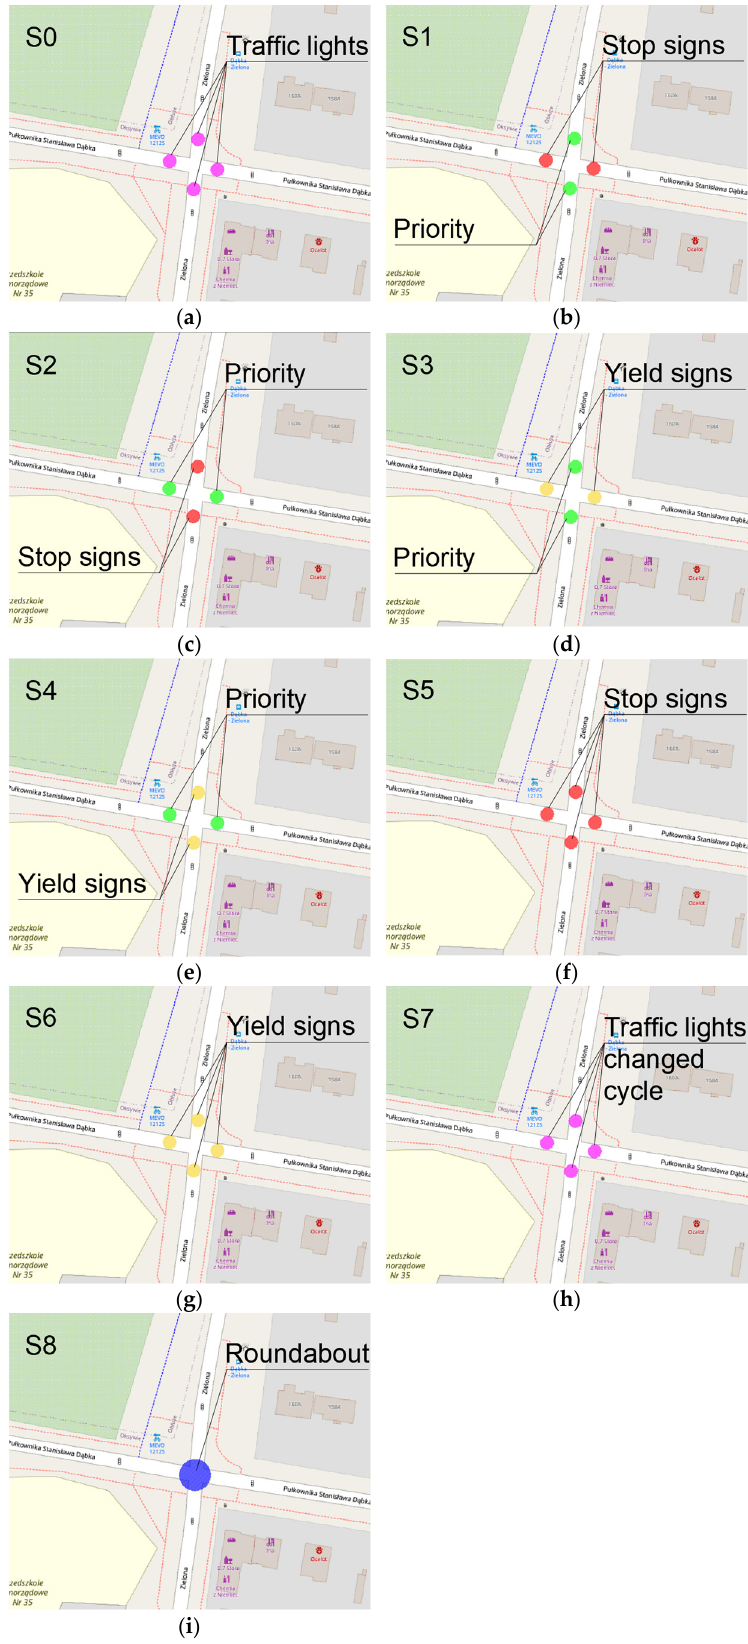
Figure 5. Scenarios regarding traffic organization and intersection types. ( a – i ) correspond with scenarios S0–S8 included in the top-left corner of each figure.